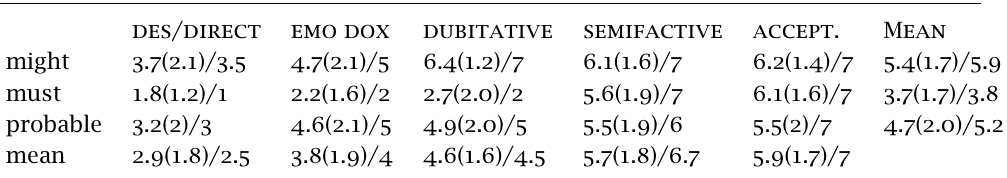
Descriptive statistics for French survey, of the form mean (stan- dard deviation)/median.